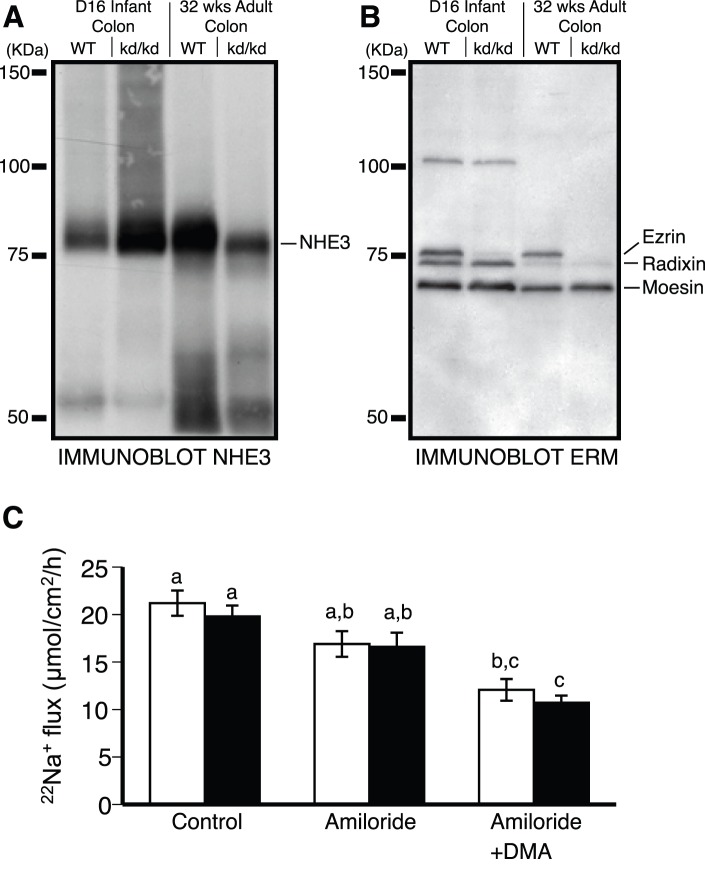
Ezrin knockdown does not alter NHE3 activity in vivo.Immunoblot analysis of colon from wildtype and Vil2kd/kd mice at day 16 (D16) pups and at 32 weeks of age (32 wks) adults for A) NHE3 and B) total ERM. C) Assessment of Na+ flux across colonic mucosa of either wild-type (WT) (white bars, n = 6) or Vil2kd/kd (black bars, n = 5) mice in the presence of 10 µM benzamil (ENaC inhibited, Control) and then also in the presence of 100 µM amiloride (NHE2 inhibited, Amiloride) and finally in the presence of the previous two drugs as well as 500 µM dimethylamiloride (NHE3 inhibited, Amiloride+DMA). Columns not sharing the same lower-case are significantly different by ANOVA.